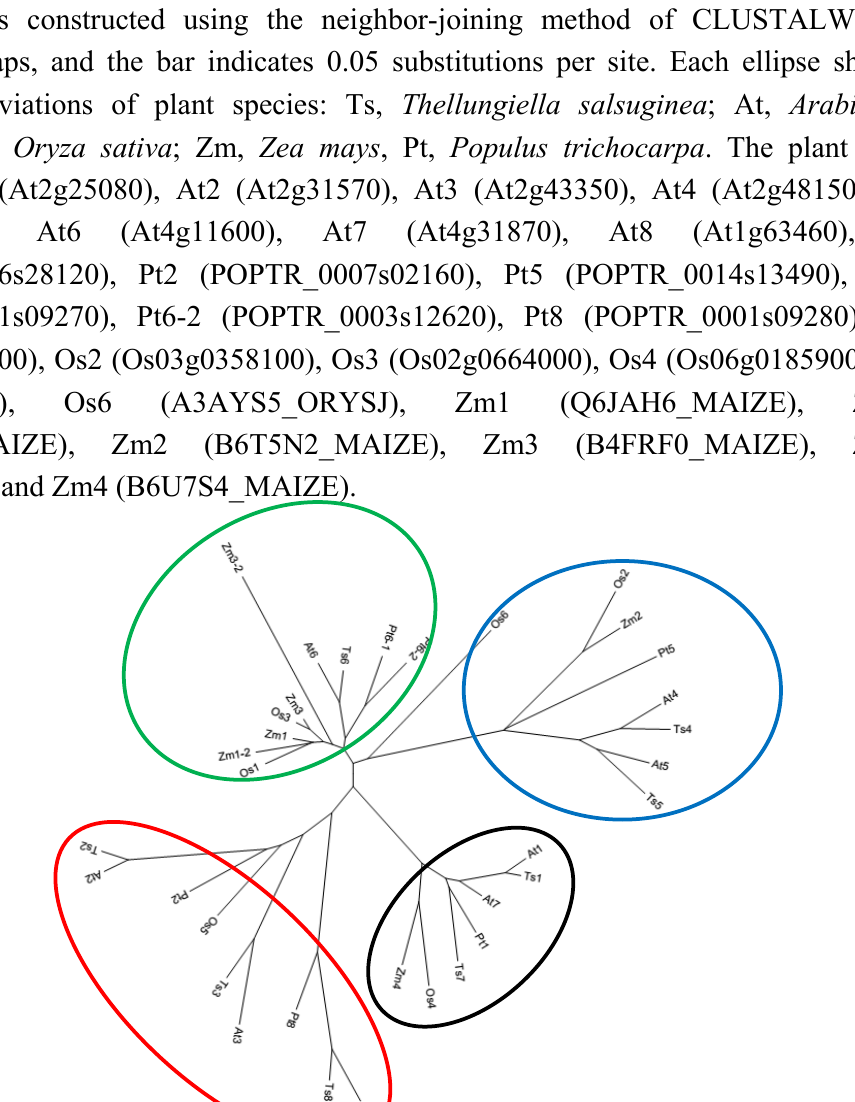
Figure 3. Phylogenetic analyses of thirty four plant glutathione peroxidase (GPX)